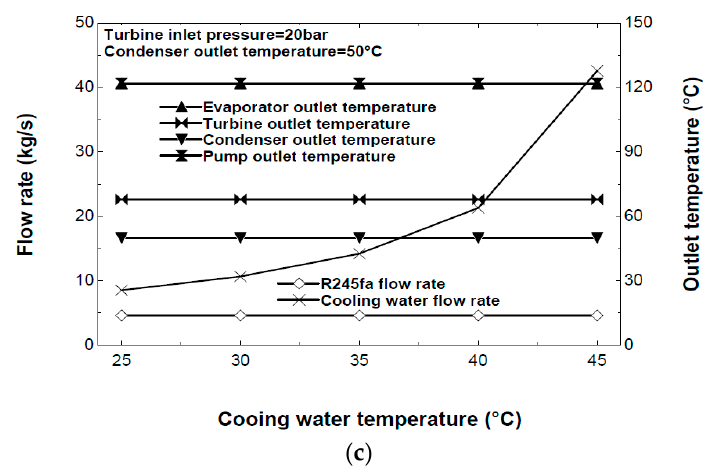
Figure 7. The effect of the cooling water inlet temperature on the performance and operating conditions of the organic Rankine cycle. ( a ) The power output and demand for the ORC components and thermal efficiency of the ORC; ( b ) The electrical efficiency of the MGT and the MGT with the ORC. The net heat rate of the MGT with the ORC; ( c ) The mass rate and the outlet temperature for the streams in the ORC.